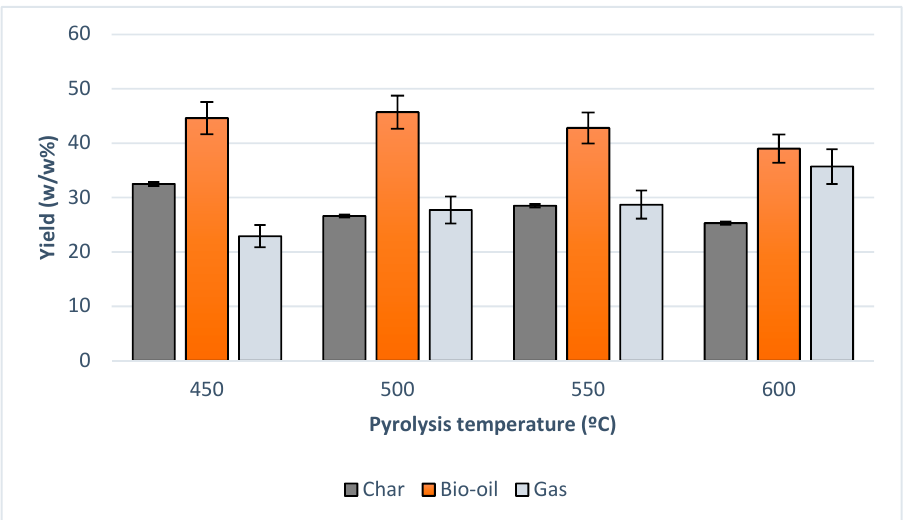
Figure 2. Variation of product yields with pyrolysis temperature for pine dust .